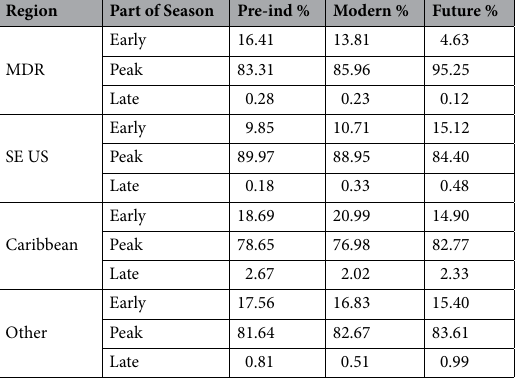
Table 2. Percentages of TC genesis within each region across parts of the season and eras.